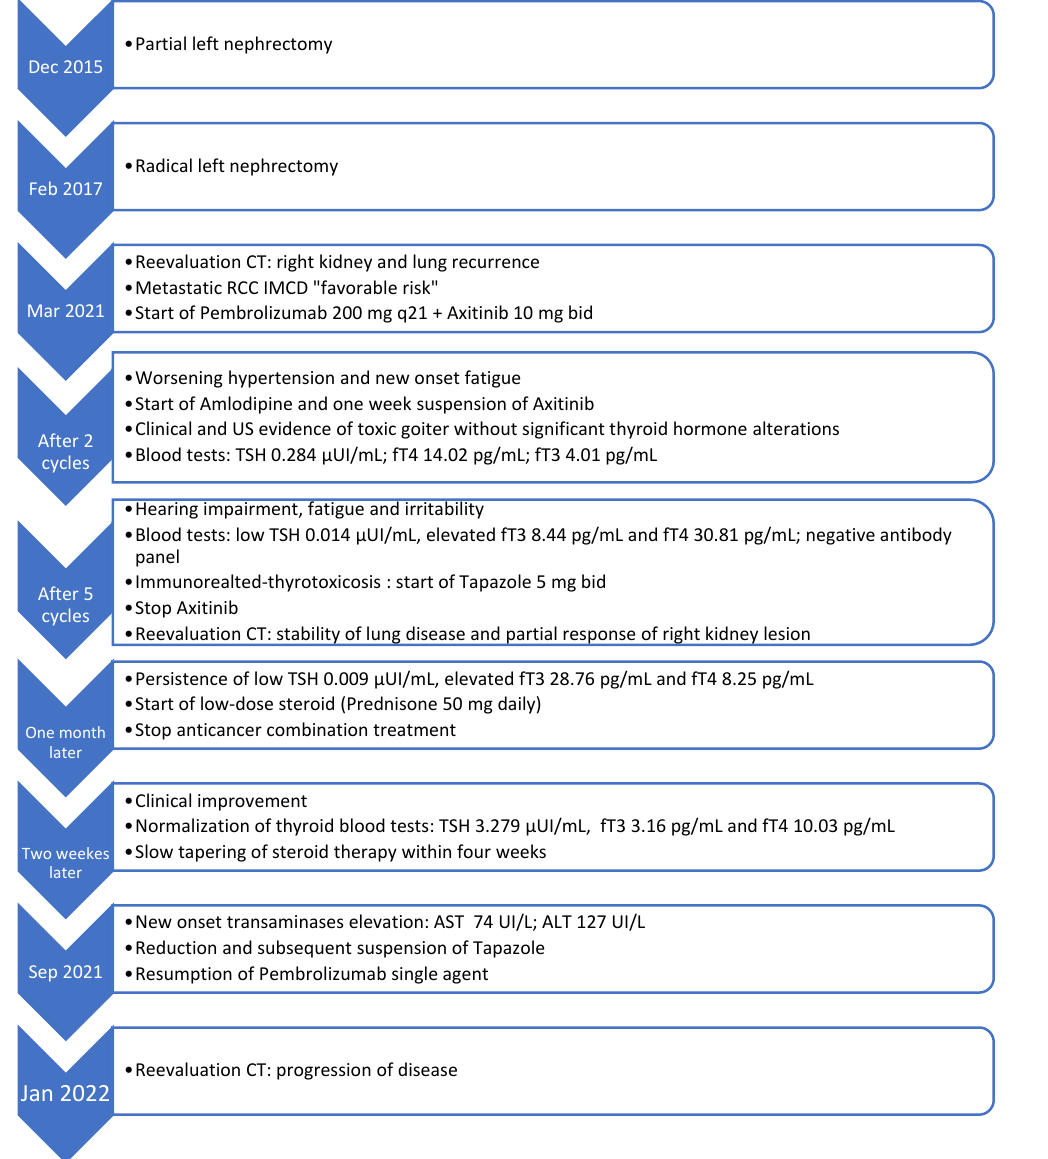
Figure 5. Events timeline of iatrogenic hyperthyroidism clinical case. RCC: renal cell cancer. IMDC: international metastatic database consortium. CT: computed tomography. US: ultrasound. ATCH: adrenocorticotropic hormone. fT3: free triiodothyronine. fT4: free thyroxine. G2: grade 2. AST: aspar- tate aminotransferase. ALT: alanine aminotransferase. Normal ranges: TSH 0.4000–4.000 µ